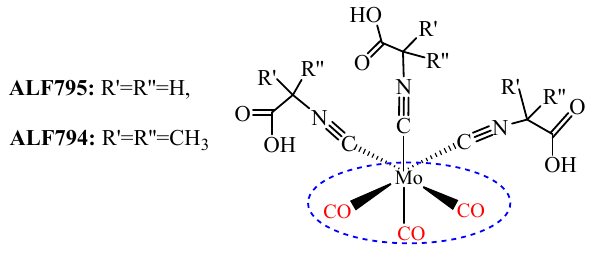
Figure 20. β -isocyanate coordinated molybdenum carbonyl Figure 20. β‐ isocyanate coordinated molybdenum carbonyl complexes. Figure 20. β‐ isocyanate coordinated molybdenum carbonyl complexes. Figure 20. β‐ isocyanate coordinated molybdenum carbonyl complexes.